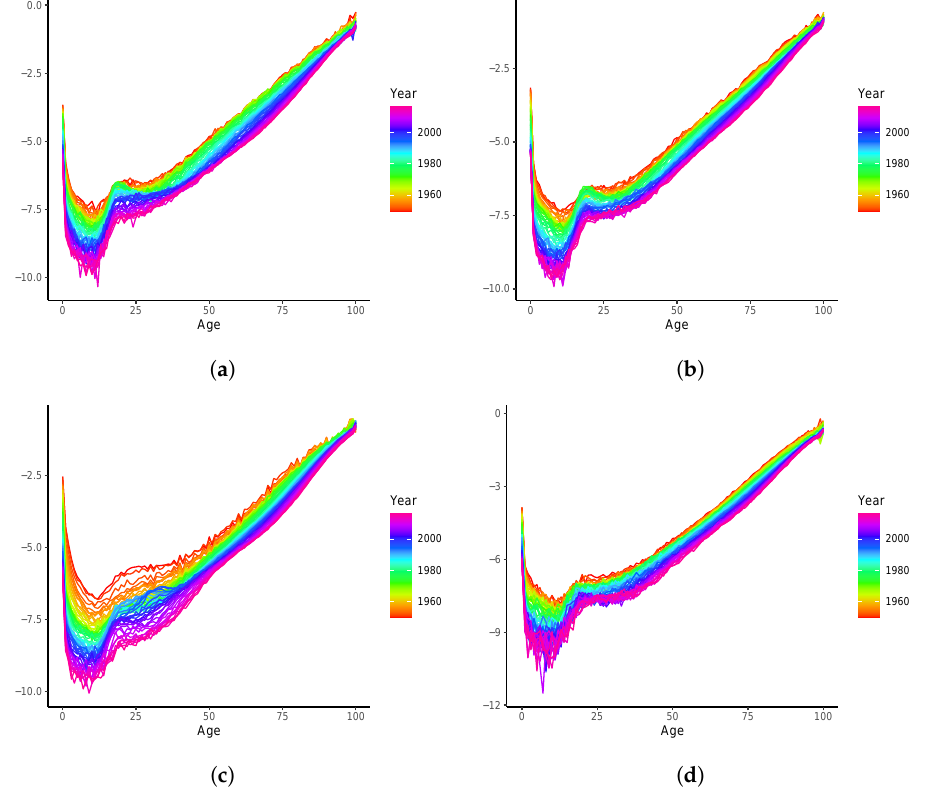
Figure 4. Mortality rates (ln m x , t ) over 1950–2019:( a ) Australia; ( b ) Canada; ( c ) Spain; ( d )